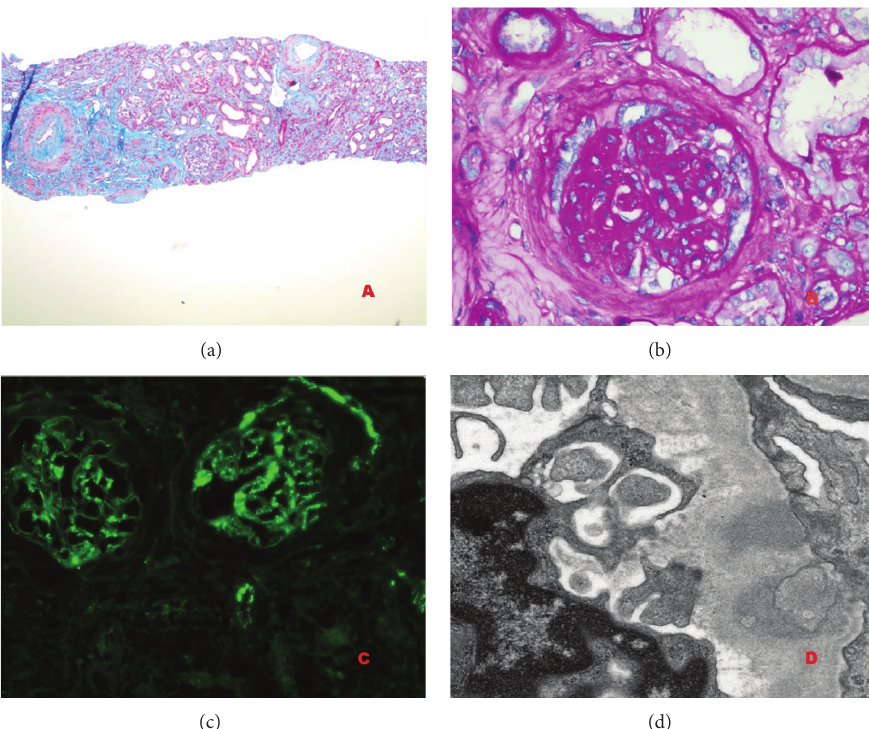
Figure 1: (a) Masson trichrome stain (100x) revealed severe interstitial fibrosis, thickened arterioles, and mild proliferation of glomeruli. (b) PAS stain (600x) showed mild mesangial proliferation and segmental sclerosis. No extra capillary crescent or necrosis was identified. Six of 10 glomeruli were globally sclerosed. (c) IF showed 2-3+ IgG and C3 deposit mainly in mesangium and also along the capillary loops. (d) Electron microscopy showed intramembranous and subepithelial electron dense deposits with occasional subendothelial and mesangial deposits. There were segmental foot process effacement and focal mesangial